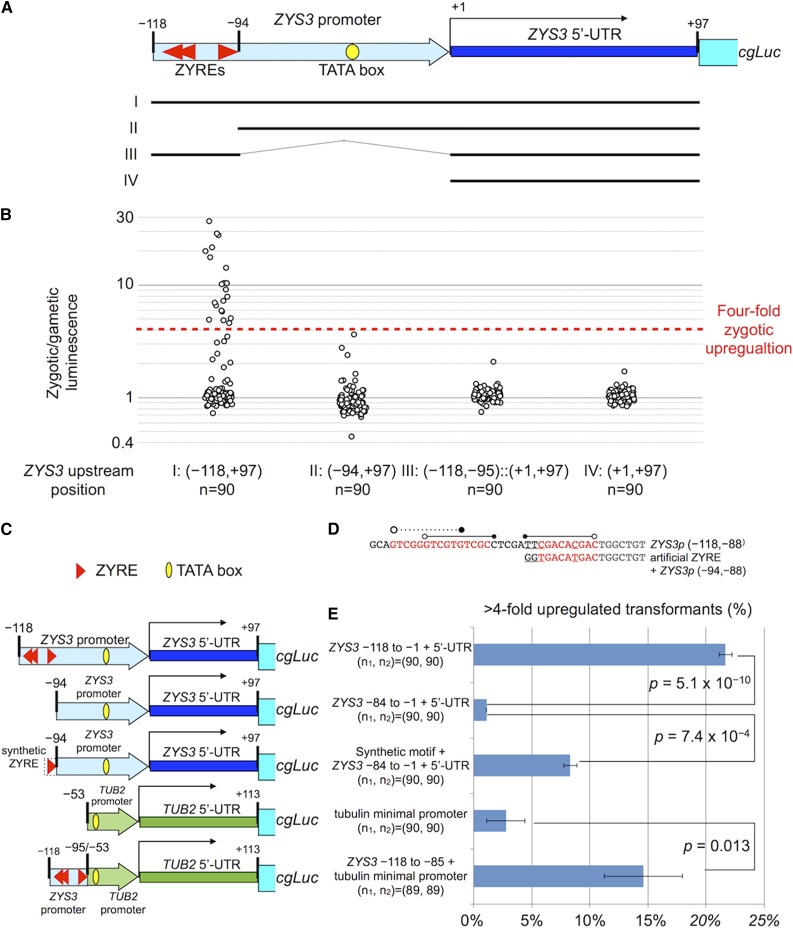
Functional characterization of the ZYRE motif using luciferase reporter constructs. (A) Schematic diagram of ZYS3 promoter and deletion variants I−IV that were tested for zygotic luciferase expression. (B) Gametes from n = 90 mt+ transformants with indicated construct (I−IV) were mixed with mt+ gametes (negative control); or mt− gametes, allowed to mate, and then assessed for luciferase activity. Ratios of luminescence values of zygotic mixtures over negative controls are plotted. (C) Schematic diagram of promoters used to test sufficiency of ZYRE element for activating zygotic gene expression. Constructs were made using either the ZYS3 promoter or a tubulin minimal promoter (Davies et al. 1992; Quinn and Merchant 1998) with the ZYS3 ZYRE elements or a synthetic ZYRE element. (D) Sequences from ZYS3 ZYRE elements and the synthetic ZYRE used in the constructs in panel C. (E) Percentage of transformants with zygotically upregulated luciferase expression (> fourfold compared to unmated control) from among ∼90 transformants tested in each of two biological replicates. The P-values for χ2 tests between ZYRE and non-ZYRE control constructs are indicated. Analysis of variance with Tukey’s test (95% confidence level) was also performed for the first three constructs: between ZYS3p(−118 to +97)::cgLuc and ZYS3p(−94 to +97)::cgLuc, P = 5.7 × 10−5; between synthetic ZYRE+ZYS3p(−94 to +97)::cgLuc and ZYS3p(−94 to +97)::cgLuc, P = 0.013; between ZYS3p(−118 to +97)::cgLuc and synthetic ZYRE+ZYS3p(−94 to +97)::cgLuc, P = 2.8 × 10−4.